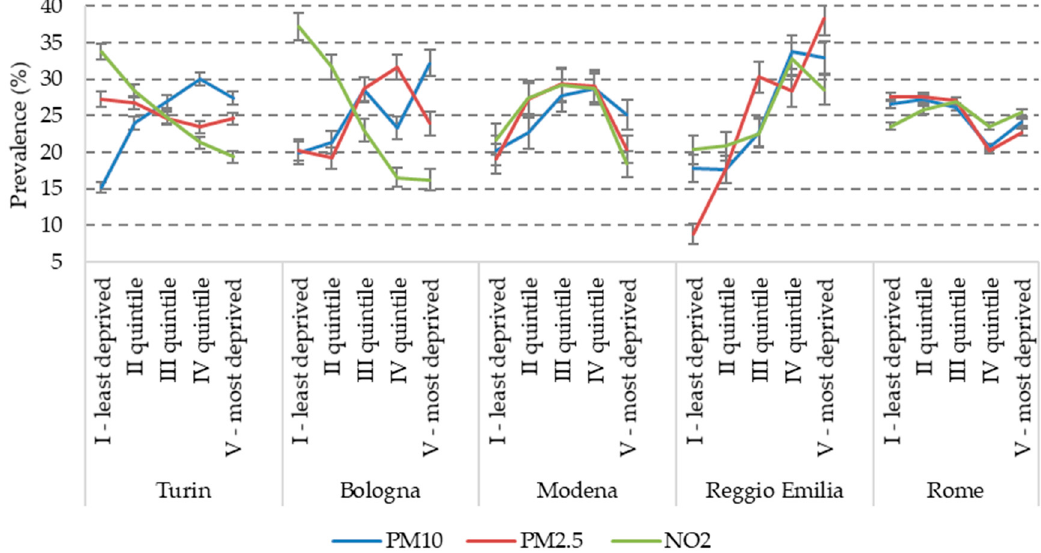
Figure 4. Prevalence of high air pollution exposure ( > 75th percentile) by city and 2011 census block deprivation index.